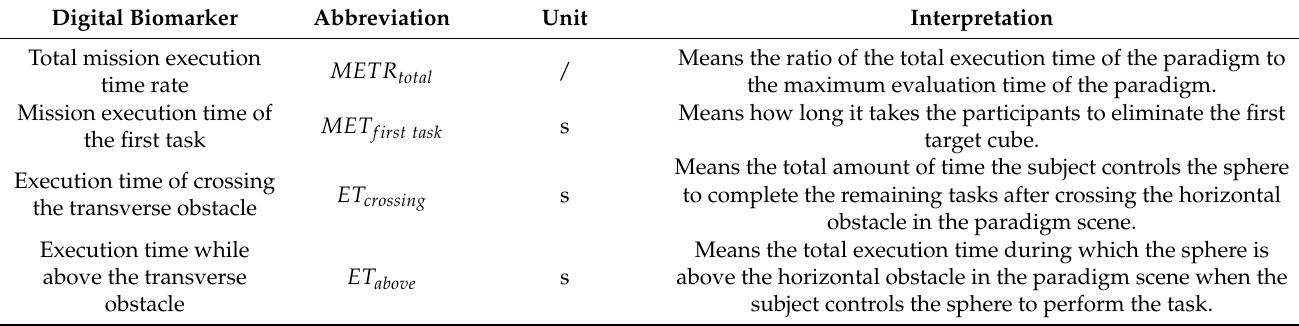
Table 2. Time-related digital biomarkers.